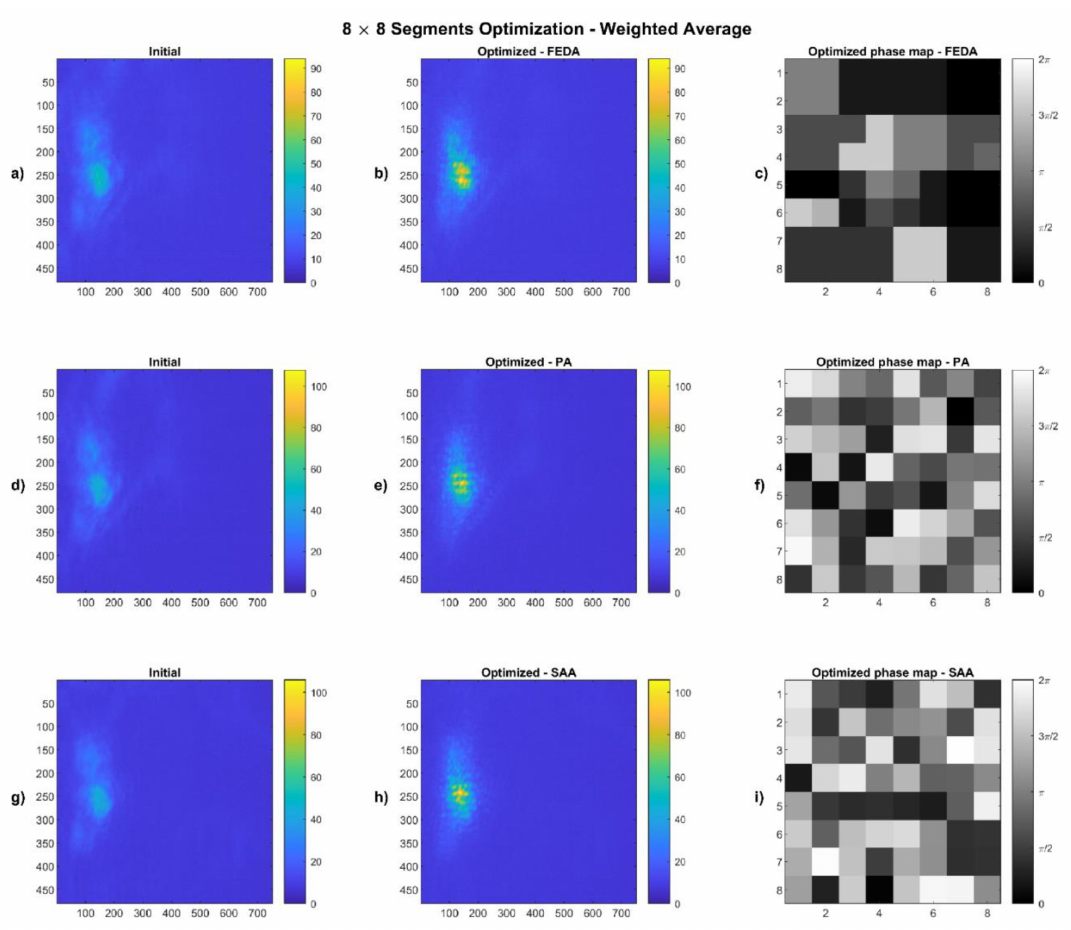
Figure 8. Results for the 8 × 8 segmentation of the phase map with the weighted average being the cost function. ( a , b ), ( d , e ), ( g , h ) stand for the initial and optimized intensity distributions captured by the CMOS when running FEDA, PA, and SAA algorithms, respectively. All initial’s intensity distributions were captured before running each algorithm and after setting the phase of the incident beam to zero. For the intensity distributions, the grid values correspond to pixel units of the CMOS and the colorbar/intensity range can have values in between 0–255. ( c , f , i ) are the achieved optimal phase maps/matrices projected in the SLM after running FEDA, PA, and SAA, respectively. For the phase maps, its values range from 0 (black) to 2 π (white) with 10 values in between this